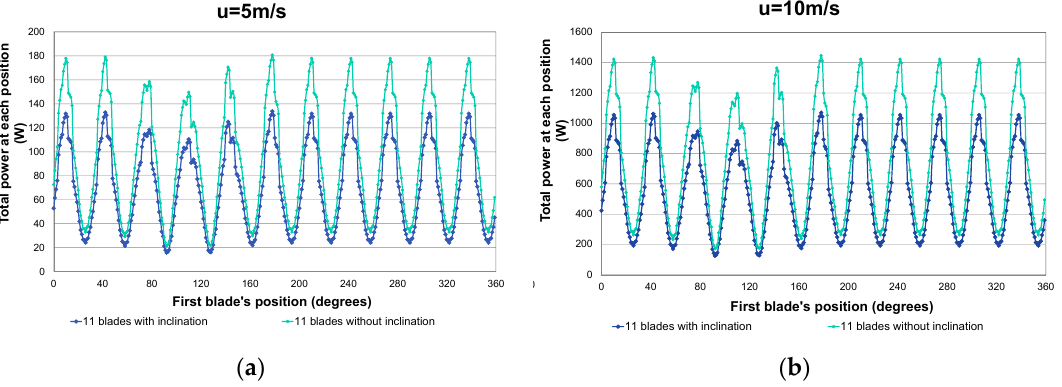
Figure 7. Total power at each blade’s position for eleven rotor blades with 25° inclination and without inclination and wind velocity ( a ) 5 m/s; ( b ) 10 m/s.